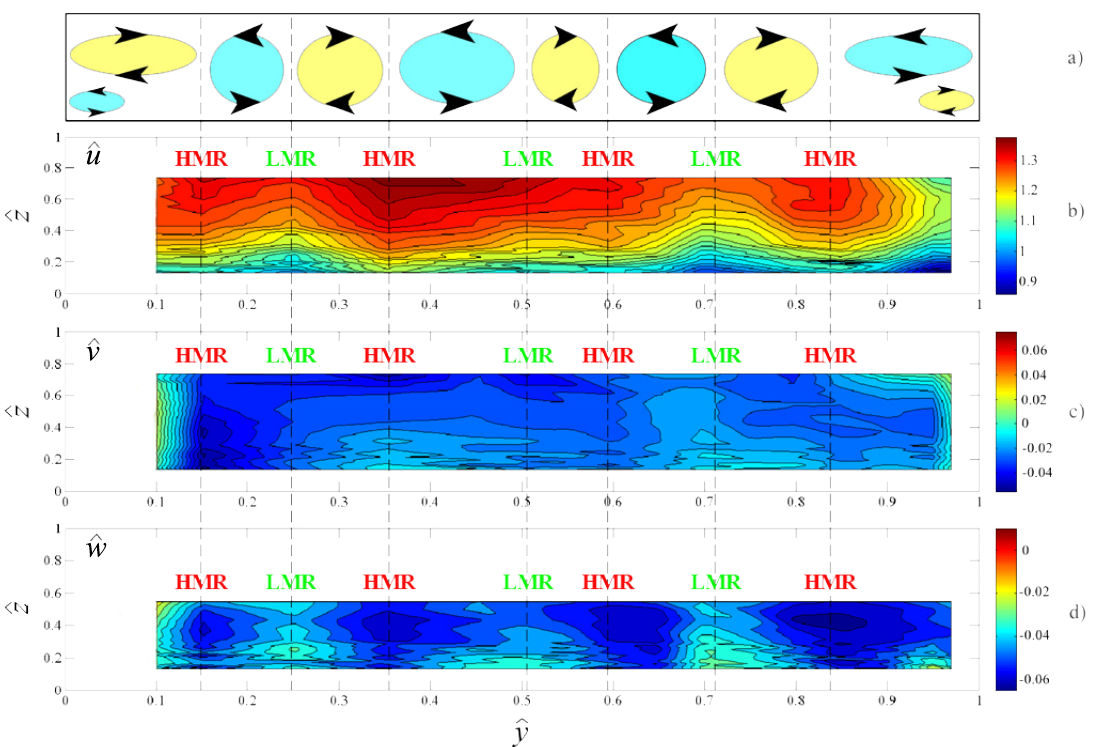
Figure 3. Patterns of some hydrodynamic variables at cross-section no. 1: ( a ) schematic of secondary currents; ( b ) normalized streamwise velocity component, ˆ u = ¯ u / U m 0 ; ( c ) normalized spanwise velocity component, ˆ v = ¯ v / U m 0 ; ( d ) normalized vertical velocity component, ˆ w = ¯ w / U m 0